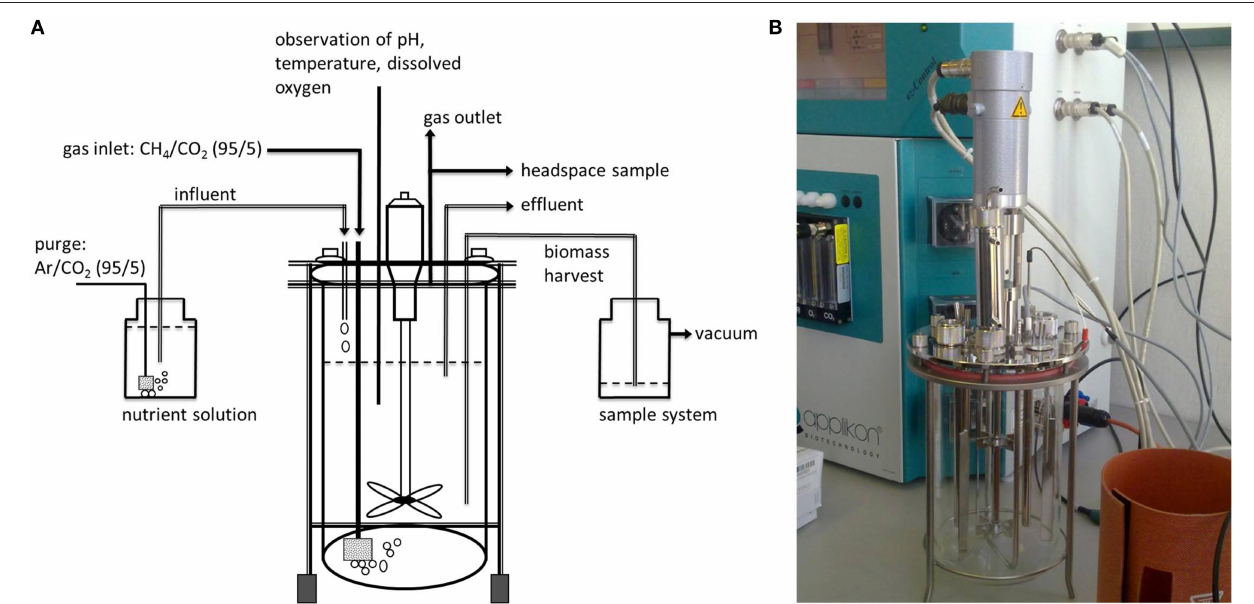
FIGURE 2 | (A) Schematic illustration of the bioreactor set up. (B) Photo of the cultivation equipment showing the bioreactor vessel together with the control unit in the background.